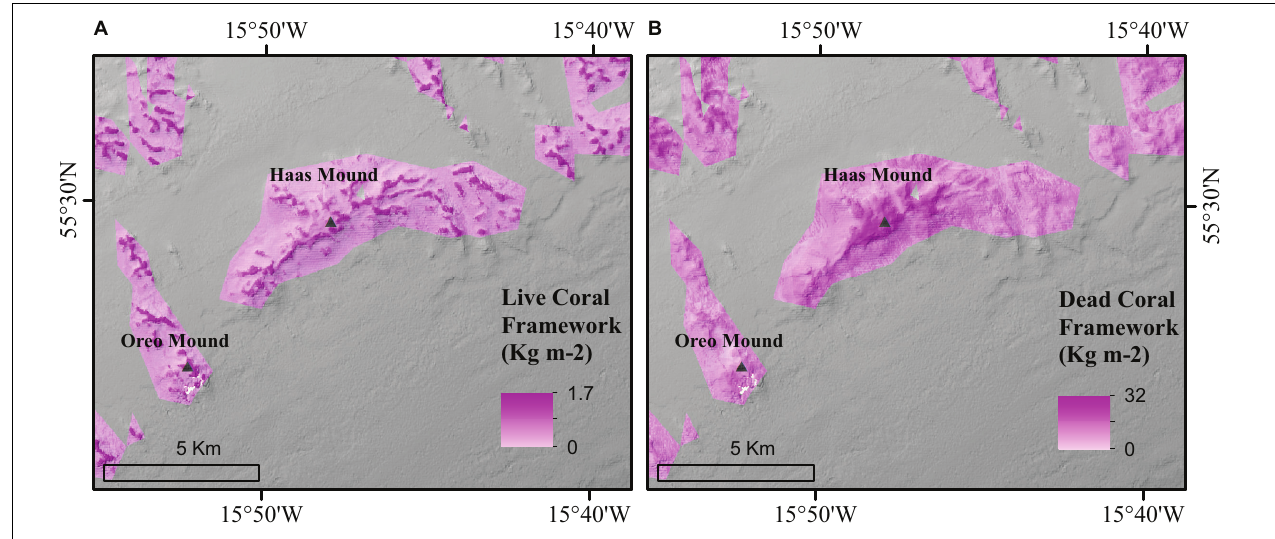
FIGURE 9 | Triangles represent the location of AEC deployment by de Froe et al. (2019) in both the predictive (A) live and (B) dead coral framework map.